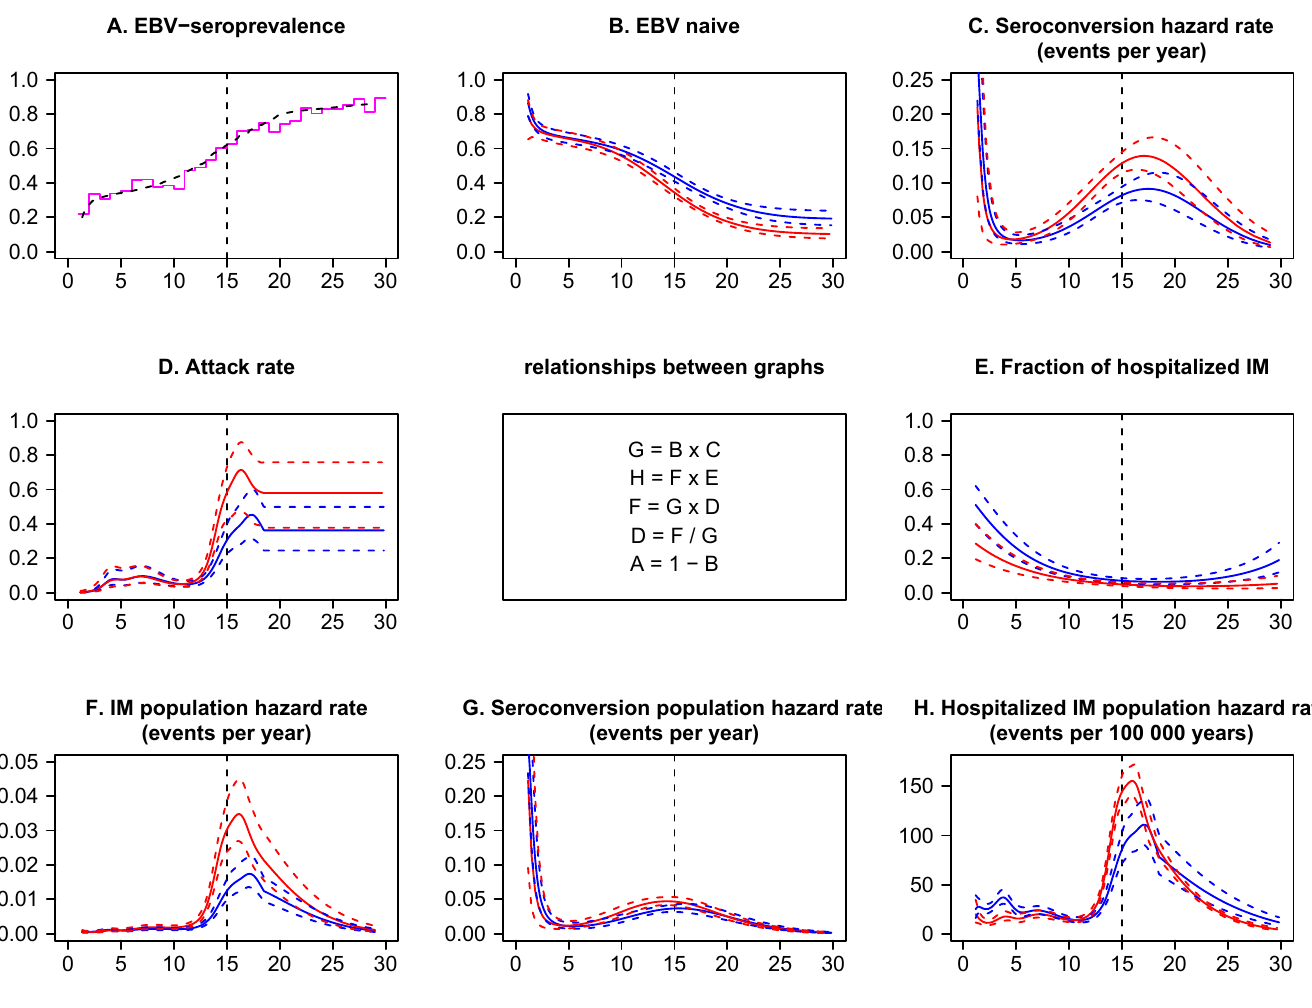
Fig 1. Model predictions with 95% confidence limits by age for females (red) and males (blue). The model was created from jointly fitting C, D, E; the results in B, F, G and H were derived from this. The flat attack rate above age 18 years in subgraph D is a self-imposed model constraint, see Methods. Subgraph A is the EBV- seroprevalence by age in Denmark in 2006–2011. The dotted line was predicted from the